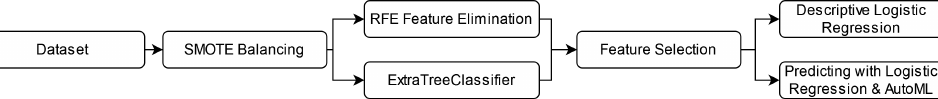
Figure 3. Data Analysis. First, the data are loaded; second, the dataset is SMOTE balanced. Third, in the feature selection phase with RFE and ExtraTreeClassifier, and fourth, the features are examined and tested. Fifth, a descriptive logistic regression and a prediction with logistic